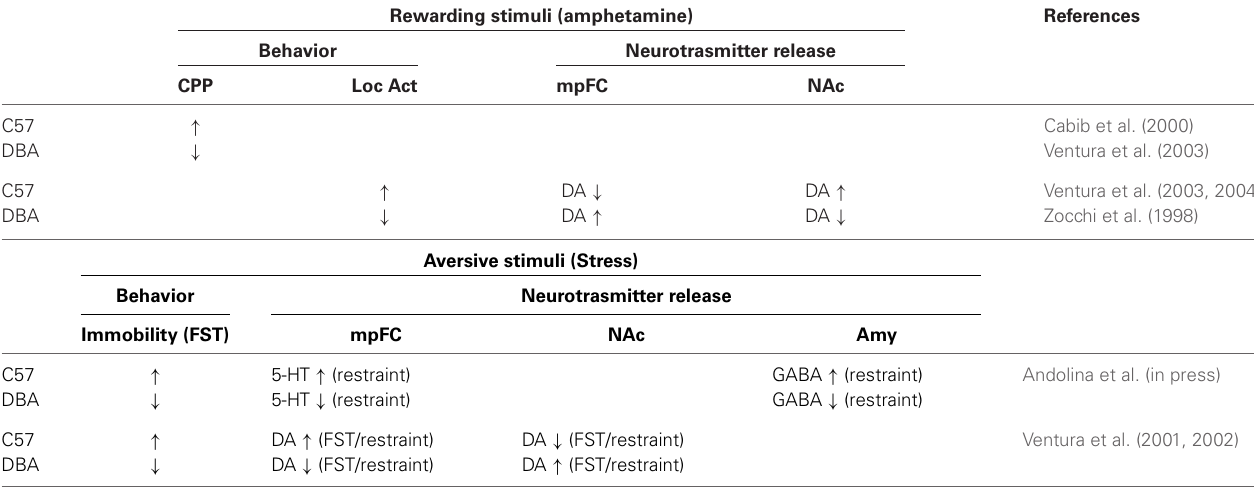
Table 1 | Summary of behavioral response and neurotrasmitter release to rewarding and aversive stimuli shown by C57 and DBA mice